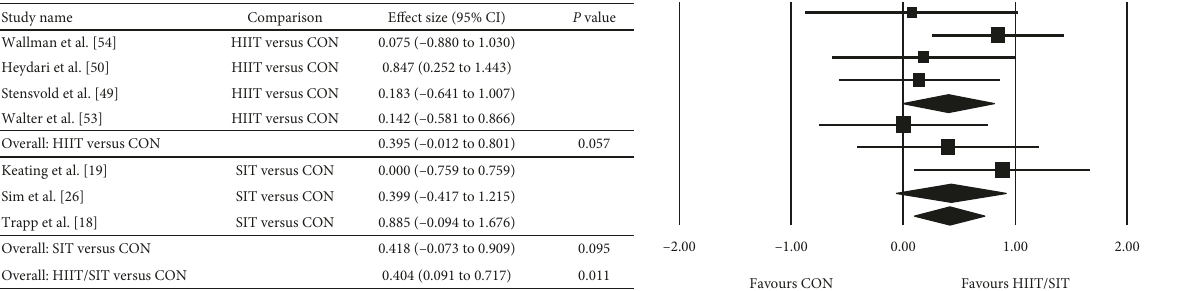
Figure 5: Meta-analysis for the comparison of HIIT/SIT versus CON on bodyweight. HIIT: high-intensity interval training, SIT: sprint interval training, CON: control, and CI: confidence interval.